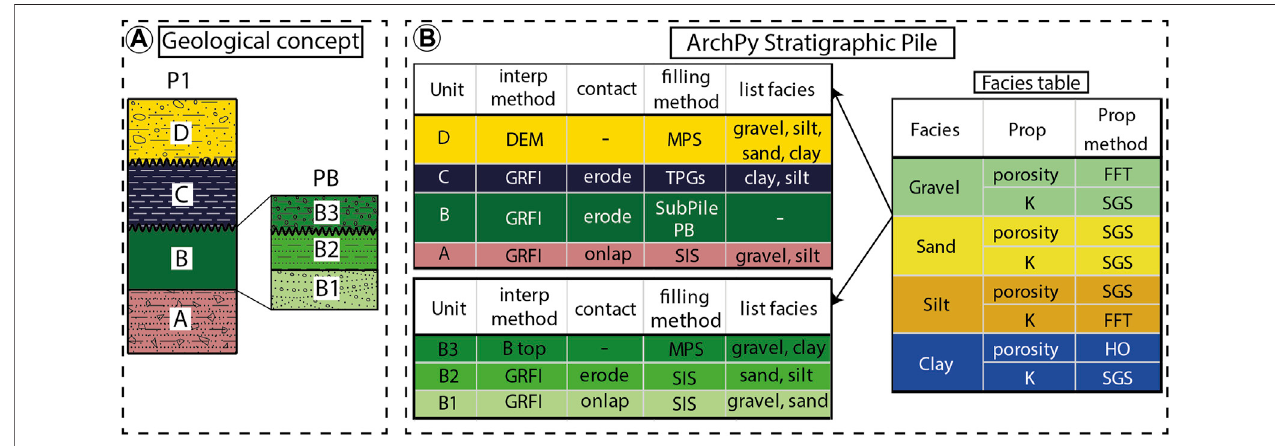
FIGURE 2 | Schematic representation of an ArchPy stratigraphic pile (B) given a geological concept (A) ; interp. method, interpolation method; GRF, Gaussian random functions; DEM, digital elevation model; Prop method, property simulation method; MPS, multiple-points statistics; SIS, sequential indicator simulation; TPG, truncated pluri-Gaussians; HO, homogeneous; K, hydraulic conductivity; FFT, fast Fourier transform; SGS, sequential Gaussian simulation.